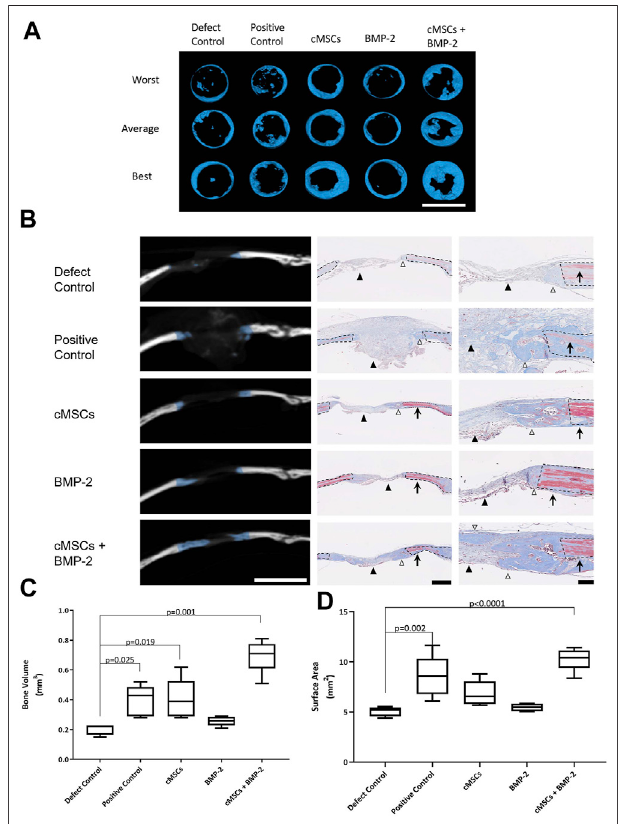
FIGURE 4 | Micro-computed tomography ( μ CT) and histological analysisofbonehealinginmurinecalvarialdefects. (A) : μ CTwasperformedat 28 days and used to create coronal plane 3D reconstructions of all calvaria. Reconstructionsrepresentingtheworst,average,andbestbonehealing response for each treatment group are provided (bar (cid:2) 4 mm). Subjectively, the bone healing responses were the greatest for the cMSC and cMSC + BMP-2 treatment groups. (B) : Frontal plane μ CT images from “ average ” specimens in panel A are depicted at the widest portion of the defect (bar (cid:2) 4 mm). Corresponding histology images were obtained at low (bar (cid:2) 500 μ m) or high (bar (cid:2) 100 μ m) magni fi cation. Masson ’ s Trichrome staining allows identi fi cation of fi brous tissue (light blue, black arrowheads), woven bone associated with bone healing (dark blue, white arrowheads), or mature, lamellar bone (red, arrows) adjacent to the calvarial defects. Dashed lines denote the margin of the surgical defect. Consistent with the coronal reconstructions in panel A, the cMSC and cMSC + BMP-2 treatment group exhibited the greatest degree of woven bone formation in the histologic sections, con fi rming the μ CT fi ndings. (C) : Quanti fi cation of bone volume (mm 3 ) at calvarial defect sites are provided for all treatment groups (box and whisker plots denote mean, 25th and 75th percentile, and range). There was no signi fi cant difference in bone volume between sub-therapeutic BMP-2 (BMP-2) and the negative control (Defect Control). There was a signi fi cant increase in bone volume for the therapeutic concentration of BMP-2 (Positive control), cMSCs alone (cMSCs), and cMSCs with sub-therapeutic BMP-2 (cMSCs + BMP-2). The cMSCs + BMP-2 treatment group exhibited the greatestbonevolumeofallgroups.Datawereanalyzed withone-wayANOVA followed by Dunnett ’ s multiple comparison test. (D) : Quanti fi cation of bone surfacearea(mm 2 )foralltreatmentgroupsasdescribedinpanelC.Therewas